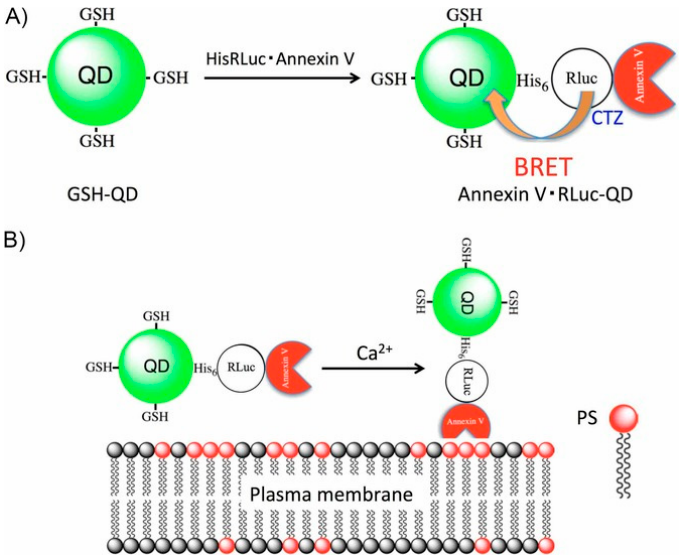
Figure 4. ( A ) Synthetic method for the preparation of recombinant protein (HisRLuc-annexin V)- conjugated QDs (annexin V-Rluc-QDs). ( B ) Schematic representation for the binding of annexin V- RLuc-QDs to PS on plasma membrane of apoptotic cells in the presence of Ca 2+ ions. Reprinted with permission from [56]. Copyright 2017 John Wiley and Sons.